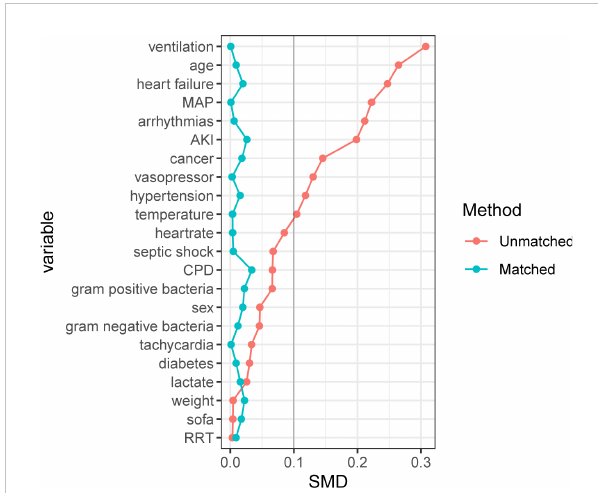
FIGURE 2 Standardized mean difference of variables before and after propensity score matching. SMD, Standardized mean difference; MAP, mean arterial pressure; AKI, acute kidney injury; CPD, chronic pulmonary disease; SOFA, sequential organ failure assessment; RRT, renal replacement therapy. For data analysis the R package ‘ MatchIt ’ was